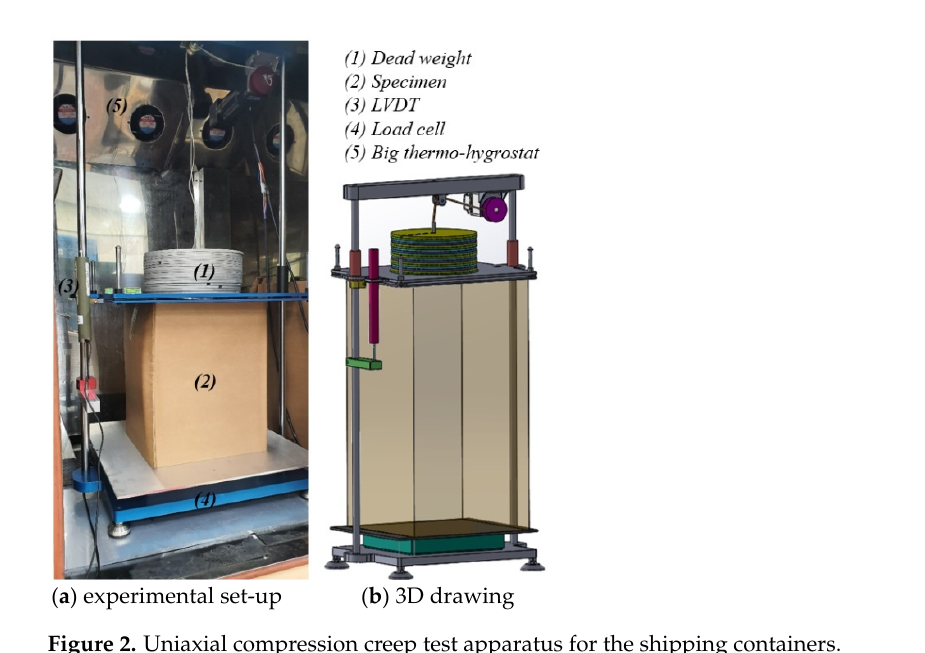
Figure 2. Uniaxial compression creep test apparatus for the shipping containers.